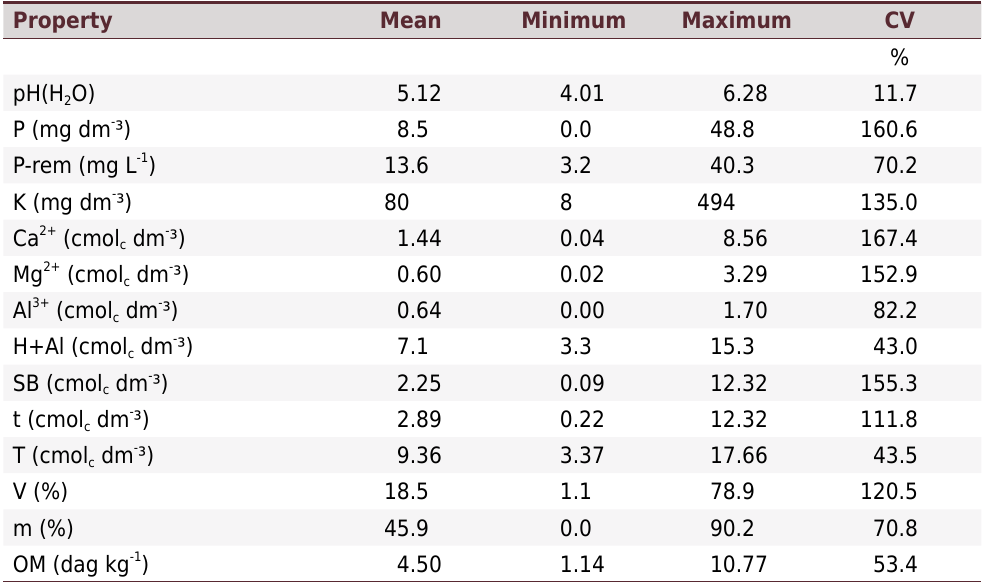
Table 2. Mean, minimum, and maximum values and coefficient of variation (CV) of the results of chemical analysis of the 26 soil samples Property Mean Minimum Maximum CV